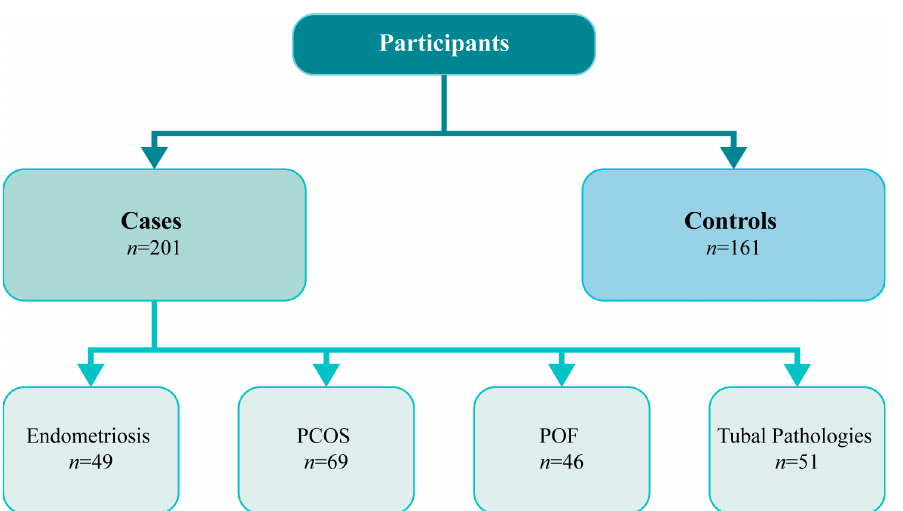
Figure 1. Flowchart diagram of participants of the study.